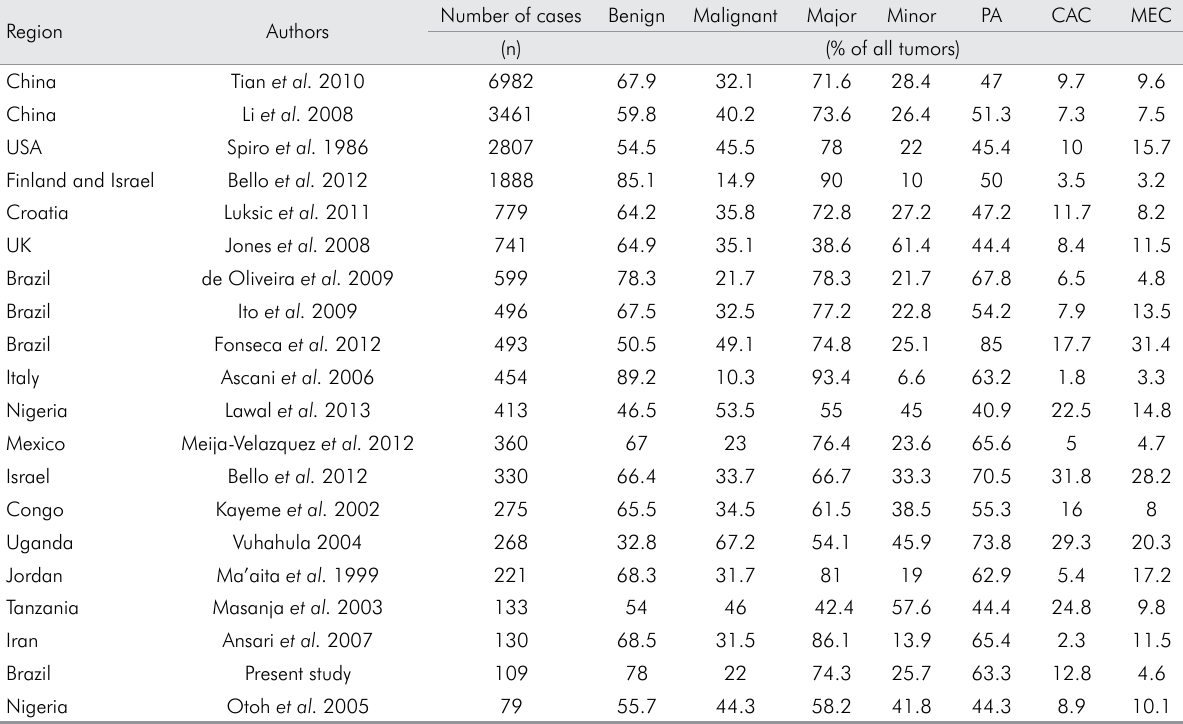
Table 4. Distribution of salivary gland tumors in different countries.